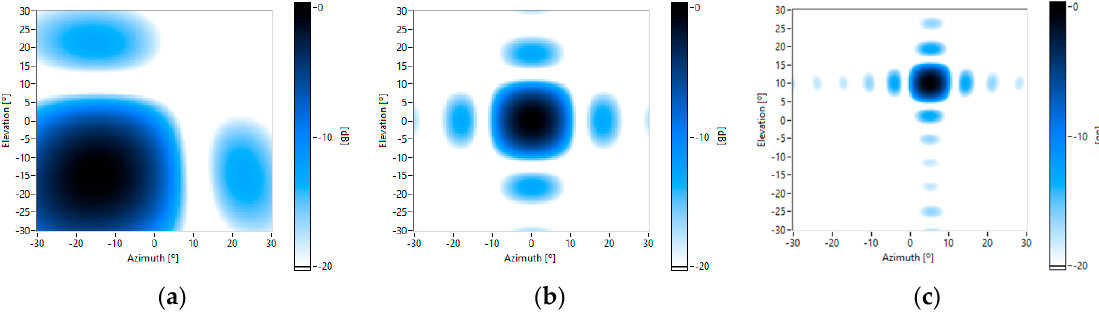
Figure 8. Theoretical beam patterns for different frequencies and pointing to different steering angles [azimuth, elevation]: ( a ) 4 kHz [ − 15°, − 15°]; ( b ) 8 kHz and [0°, 0°]; and ( c ) 16 kHz and [5°, 10°].